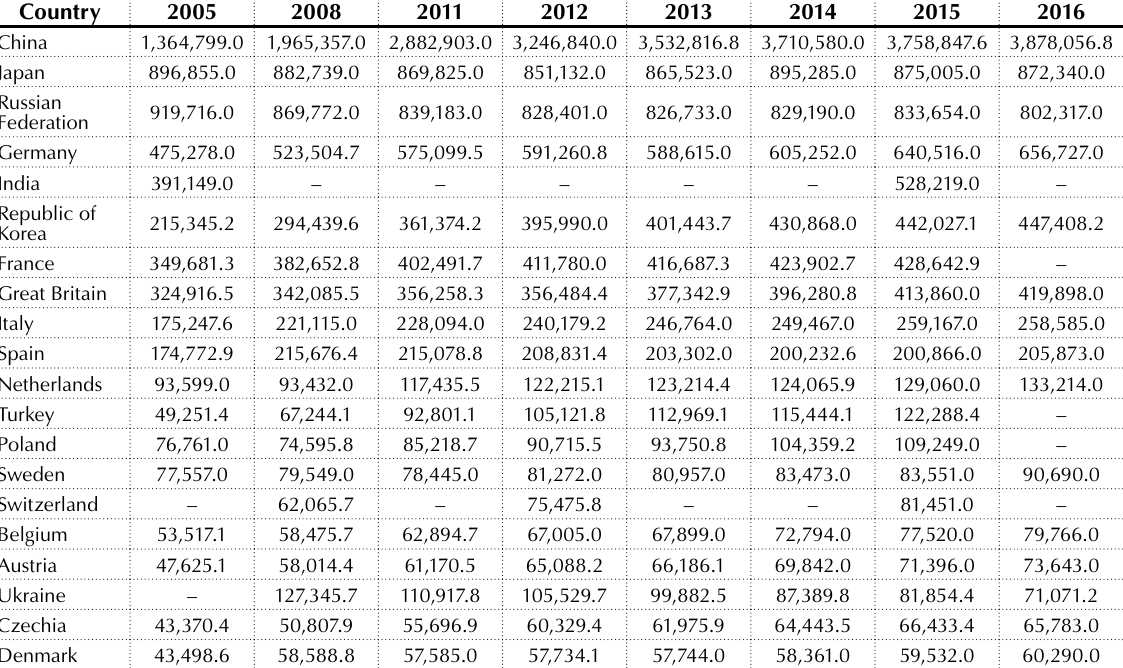
Table 6. TOP-20 countries by total R&D personnel (in full-time equivalents and headcounts),